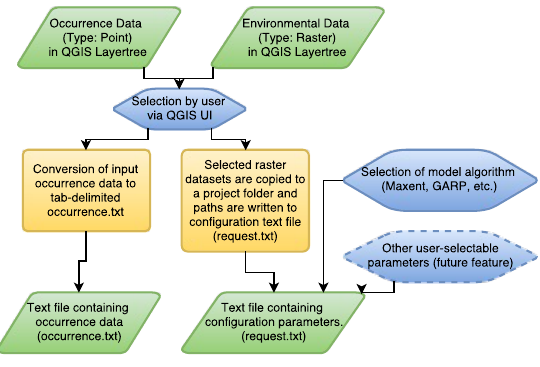
Figure 2: Chart of the plugins